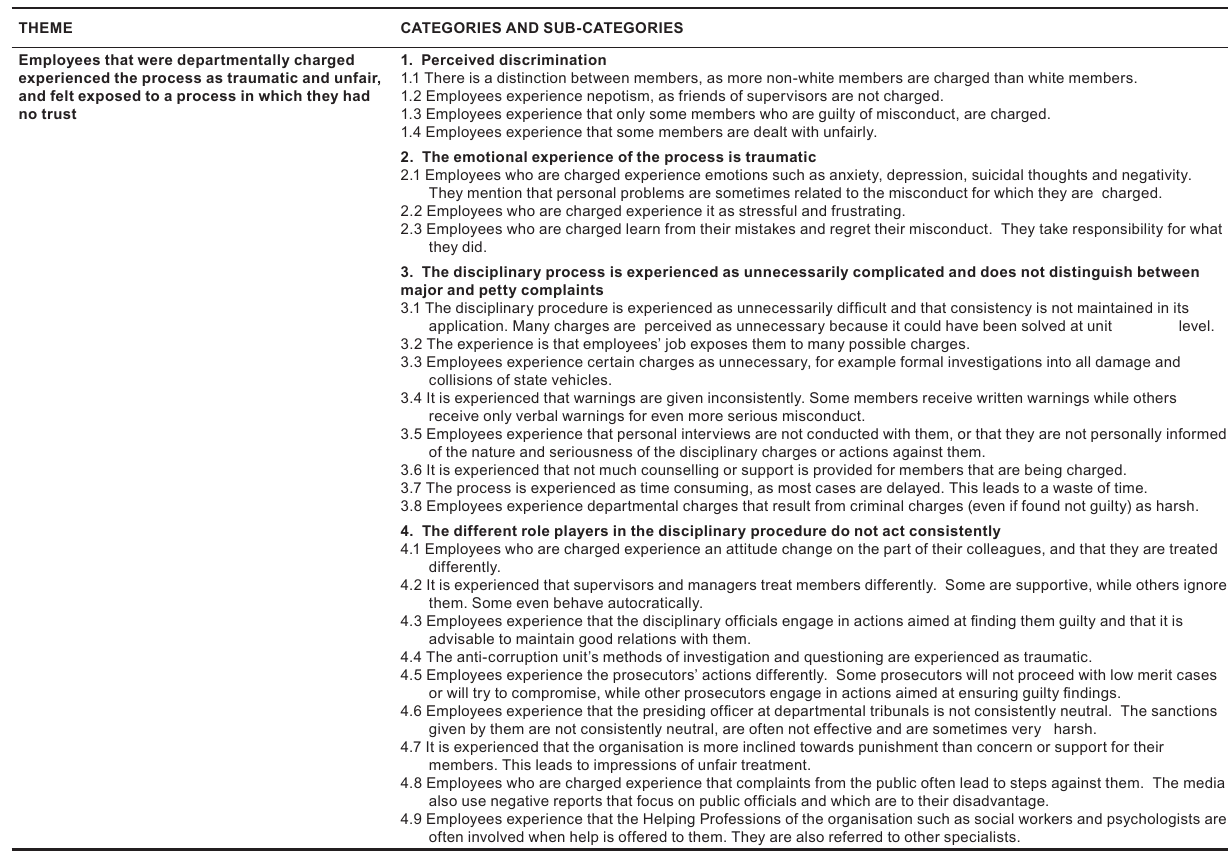
Category 4: The different role players in the disciplinary procedure do not act